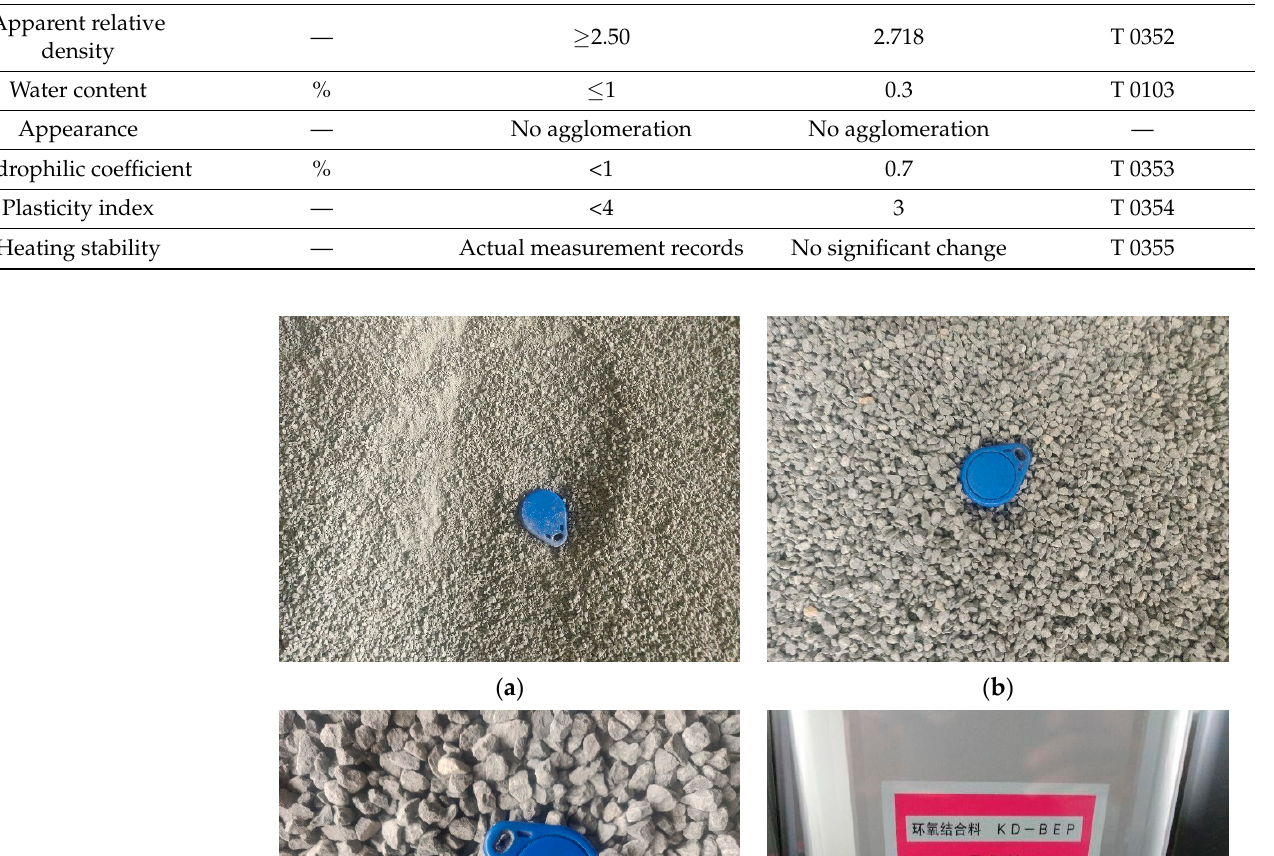
Table 7. Mineral powder test results.